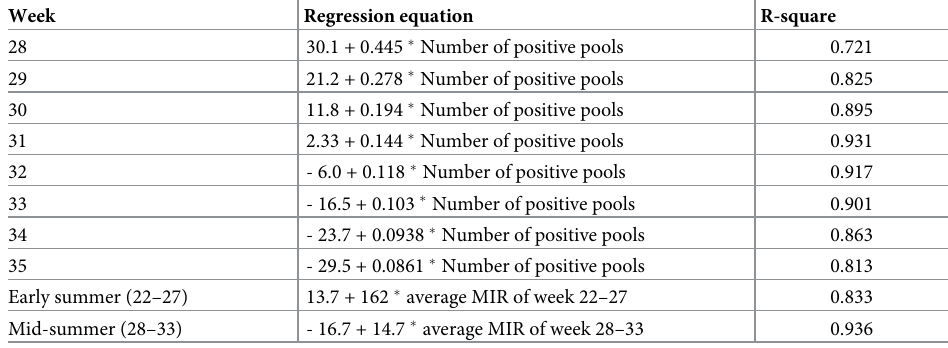
Table 4. The regression equations of the relationship between a cumulative number of WNV positive pools, mos- quito infection rate in a six-week period early and mid-summer and human West Nile virus illnesses for the year for Cook and DuPage counties from